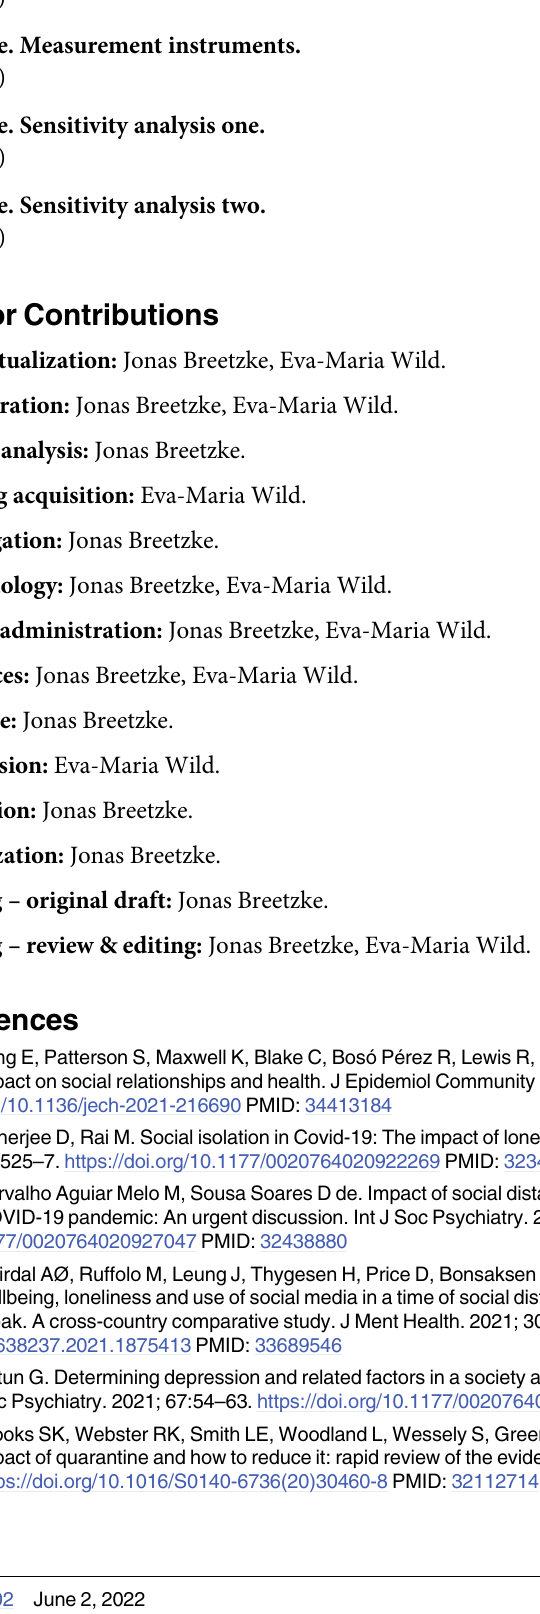
S1 Table. Measurement instruments. S2 Table. Sensitivity analysis one. S3 Table. Sensitivity analysis